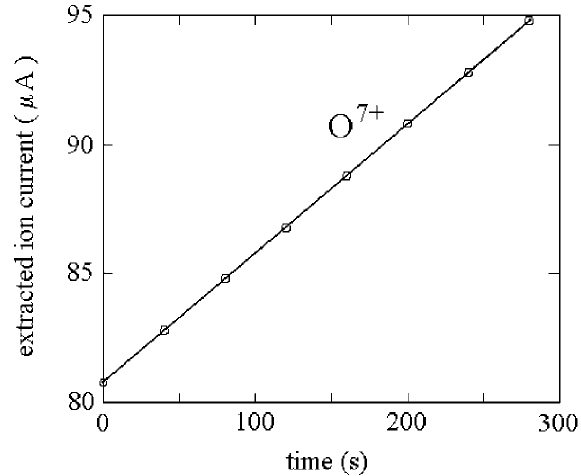
FIG. 3. The diagram shows the increase of the MCIs current with time after the switching on of the electron source. The stop of the curve was due to a destructive discharge at the ferroelectric